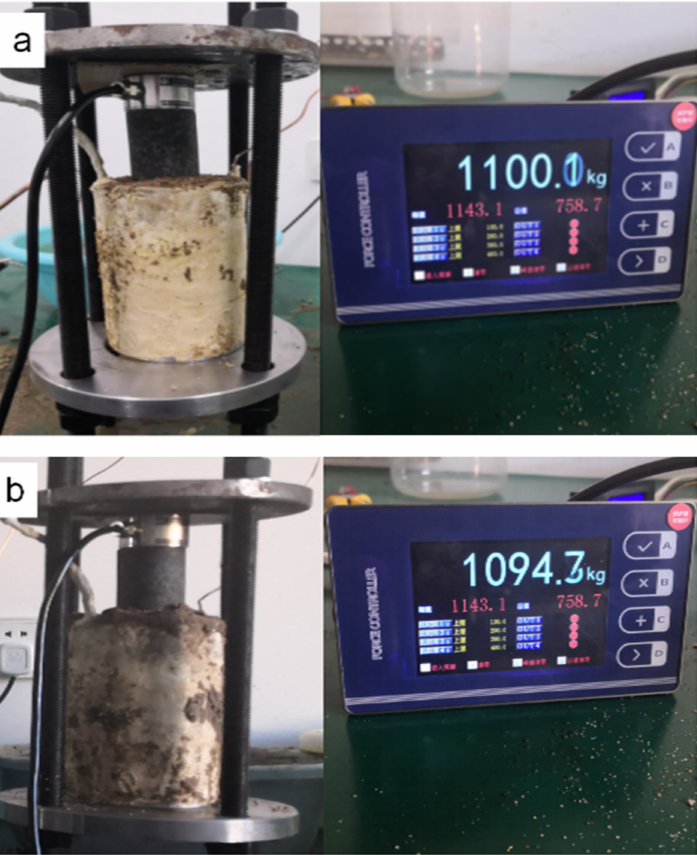
Figure 6. Bearing capacity test of the sand–ice valve: ( a ) artificial sample; ( b ) natural